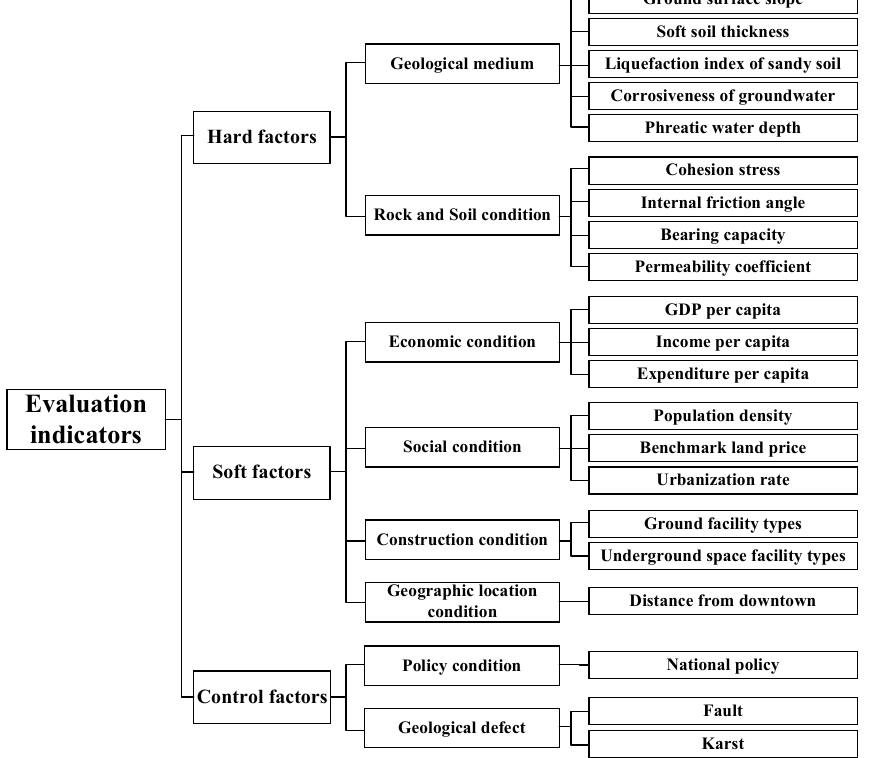
Figure 1. Evaluation indicators of urban underground space resources (UUSR) comprehensive